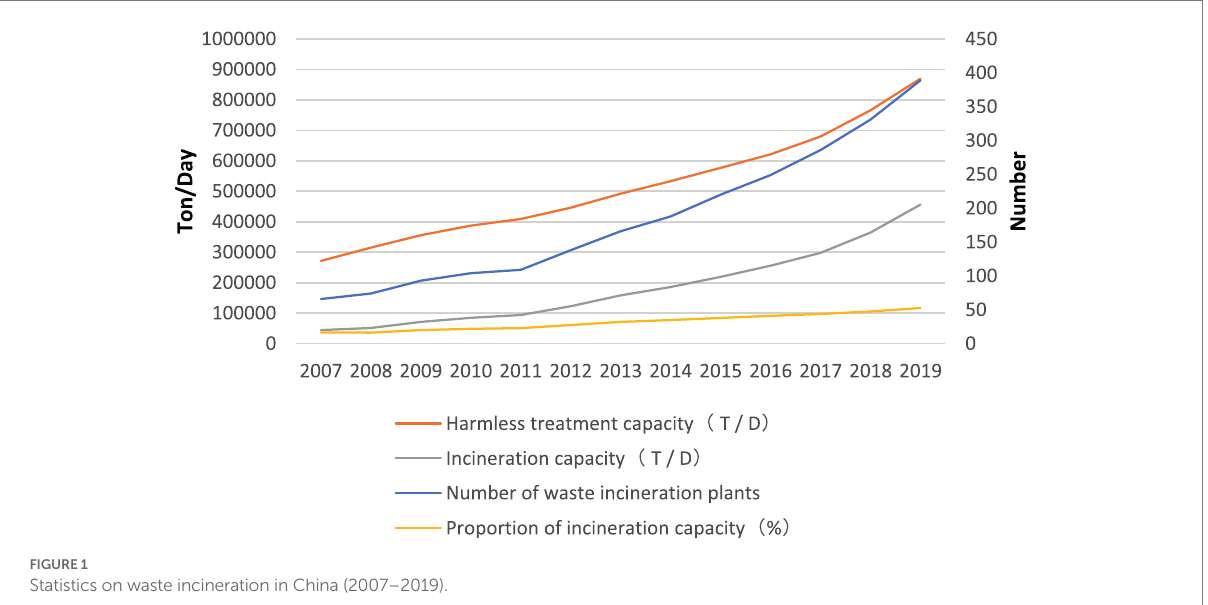
FIGURE 1 Statistics on waste incineration in China